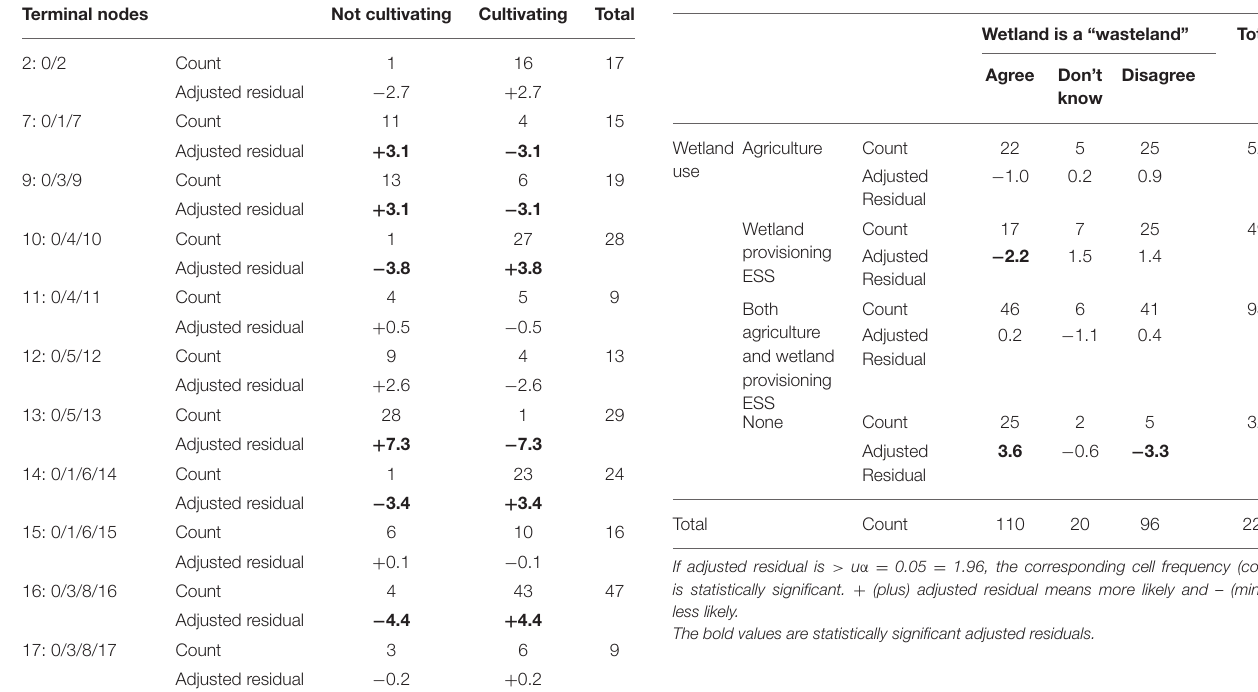
TABLE 6 | Association between the perception wetland is “wasteland” and use of the wetland. Wetland is a “wasteland”